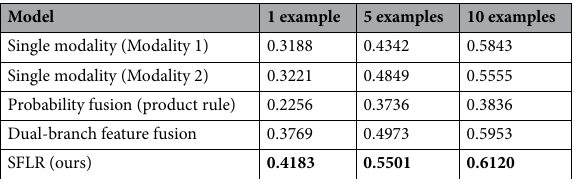
Table 4. Few-shot learning sensor fusion classification results ( F 1 macro) for synthetic proteins. Best results are shown in bold.